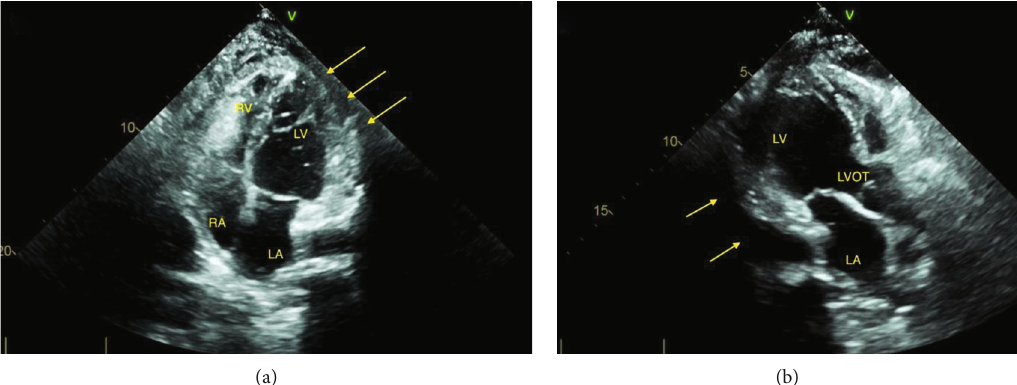
Figure 4: Transthoracic echocardiogram on day 1. The left ventricle has normal size. There is di ff use mild hypokinesis, LVEF is 45-50%. The right ventricular free wall appears thickened and echogenic. There is a small pericardial e ff usion. (a) Apical 4-chamber view and (b) parasternal long-axis view.